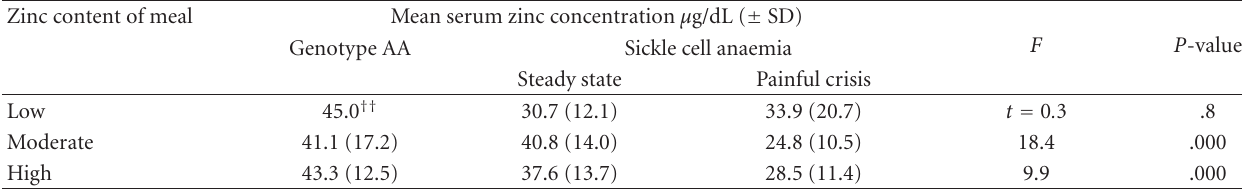
Table 2: Relationship between zinc content of 24-hour dietary recall and mean serum zinc level.